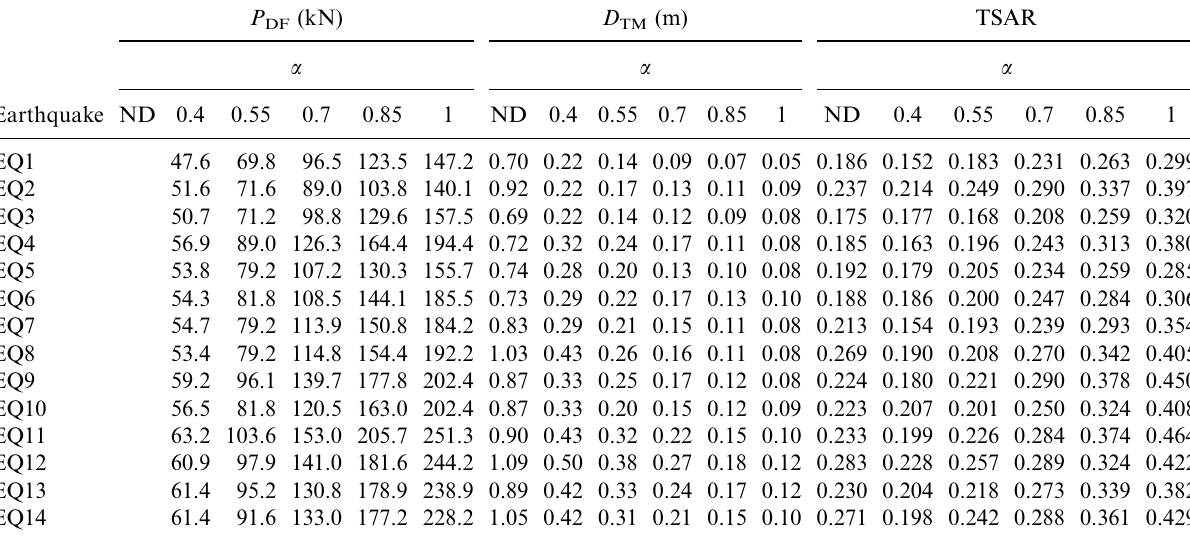
measure of the strength of association and does not reflect the extent to which any particular independent variable is associated with the dependent variable. Adjusted R 2 is an adjustment of the R 2 that penalizes the addi- tion of extraneous predictors to the model. Adjusted R 2 (cid:3) 1 (cid:6) ((1 (cid:6) R 2 )(( N (cid:6) 1)/( N (cid:6) k (cid:6) 1)), where k is the number of predictors and N is the number of data points; (cid:2) Model F -value and F -significance: The F -sta- tistic the p -value associated with it. The F - statistic is the Mean Square (Regression) di- vided by the Mean Square (Residual). The p - value is compared to some alpha level in testing the null hypothesis that all of the model coefficients are zeros; Table 7. Response parameters when C (cid:3) 525 kN-s/m P DF (kN) D TM (m) TSAR a a a Earthquake ND